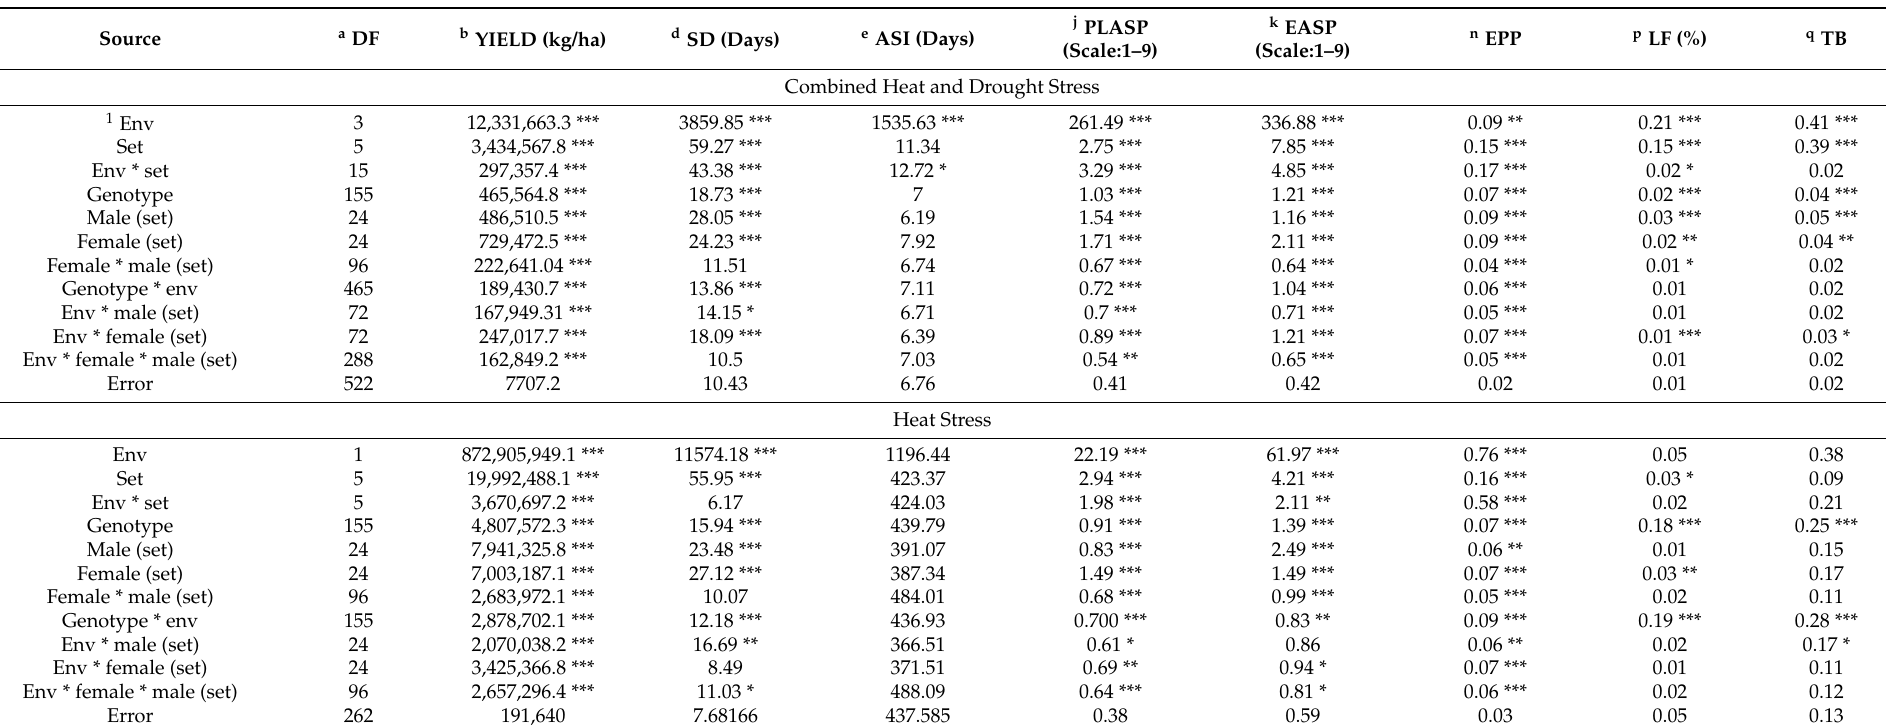
Table 1. Mean squares from combined analysis of variance of hybrid maize evaluated under combined heat and drought, and heat stress environments at Manga and Kadawa during the 2017/2018 dry